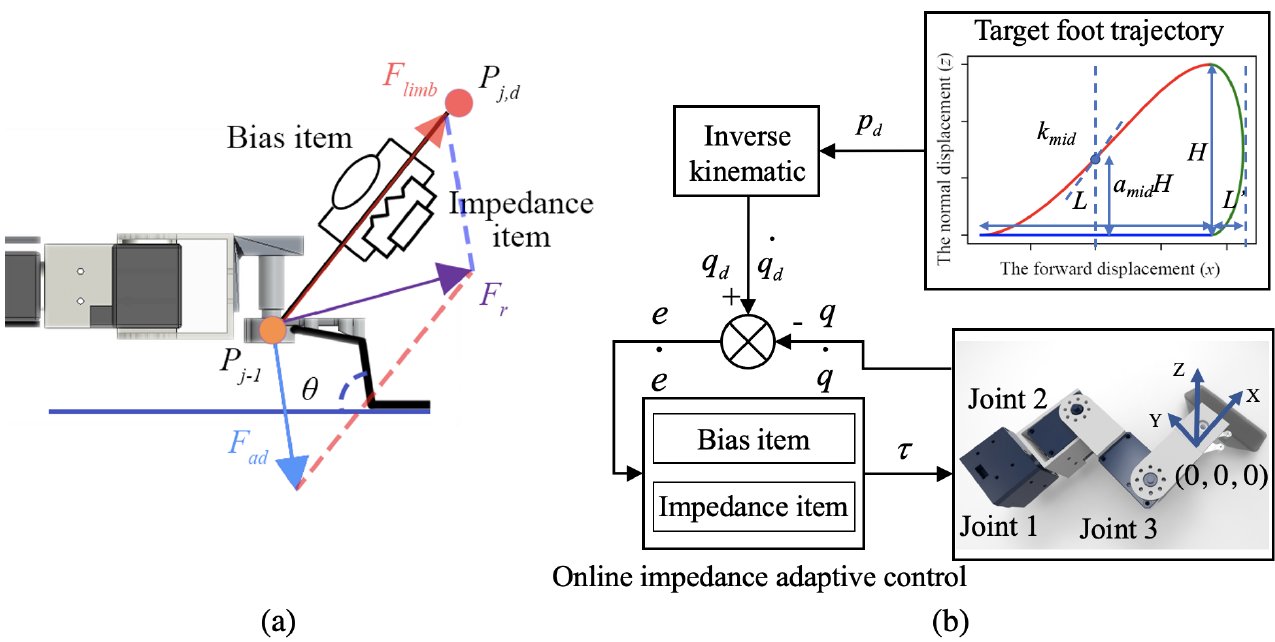
Figure 2. ( a ) Force analysis on the foot, the peeling is driven by F ad and F limb . ( b ) Motion control strategy diagram. Taking a 3-DOF limb, for example: The expected foot end coordinate of the single limb p d is given by the trajectory. The expected angle q d and angular velocity ˙ q d of the joints are obtained through the inverse kinematic of the single limb, and the feedback of the current angle q and angular velocity ˙ q is obtained. The error e is input to online impedance adaptive controller, and the joints torque are output to control the single limb. The origin position (the angles of joints 1–3 are set to 0) of the foot end is set as the coordinate original point (0, 0,